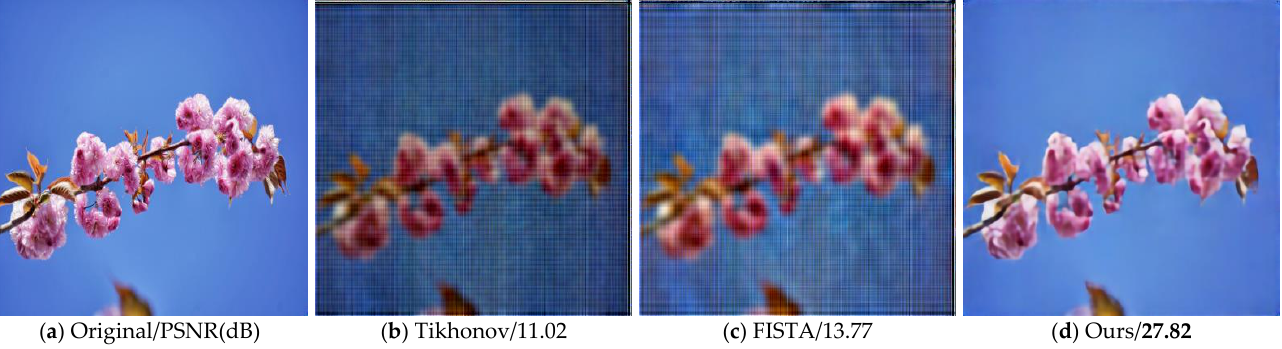
Figure 9. FlatCam imaging results on three images of ImageNet. ( a ) The results of image ‘Store’. ( b ) The results of image ‘Insect’. ( c ) The results of image ‘Boy’.